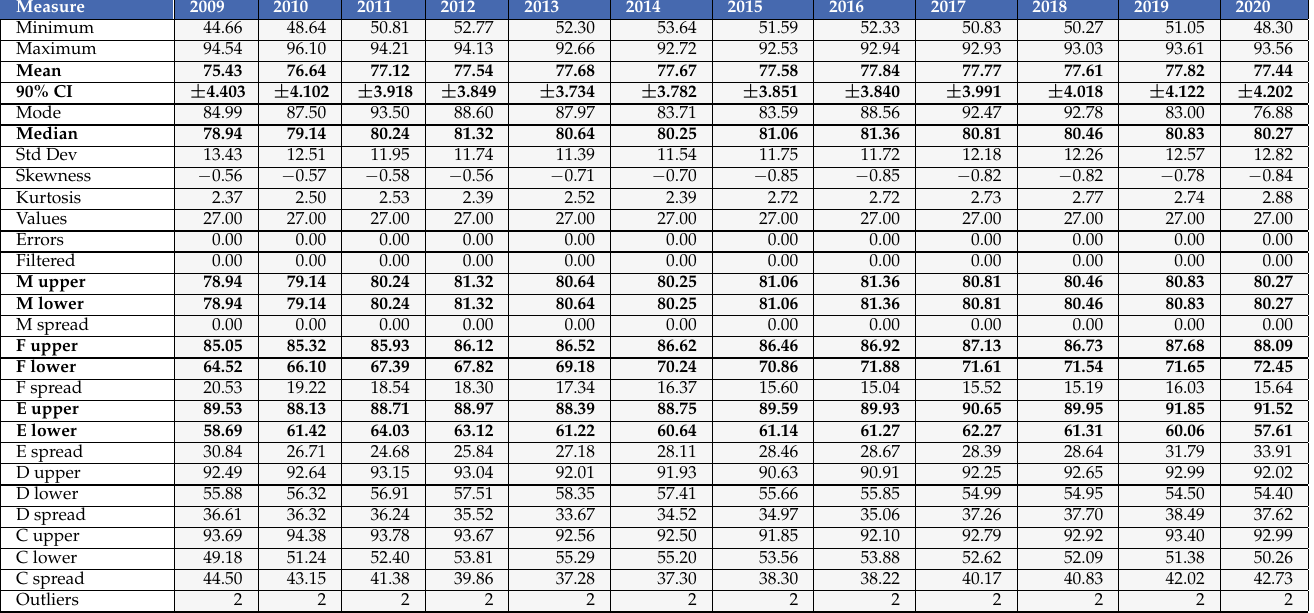
Table A4. Letter values—the share of energy tax revenues in environmental tax revenues of the EU27 in 2009–2020 (source: own